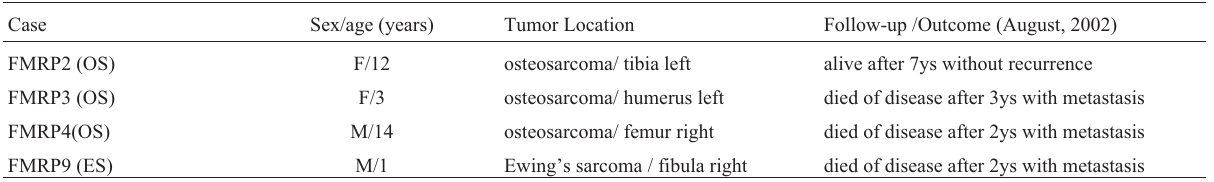
Table 1 - Clinical data on three osteosarcoma (OS) and one Ewing’s sarcoma (ES)